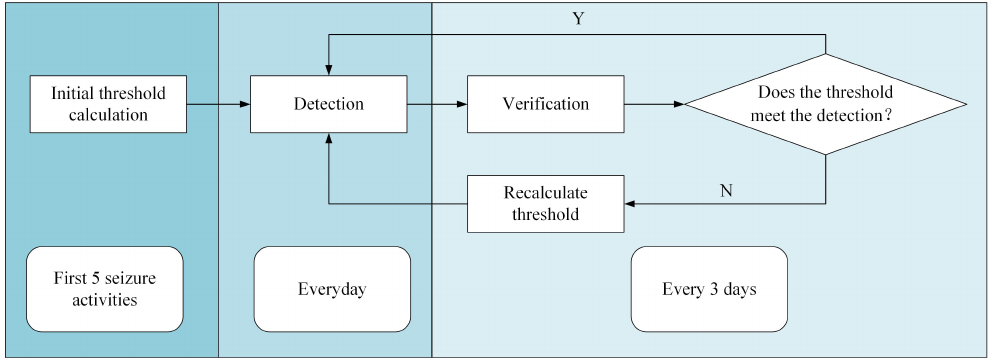
Figure 2. Flow chart of the threshold iteration